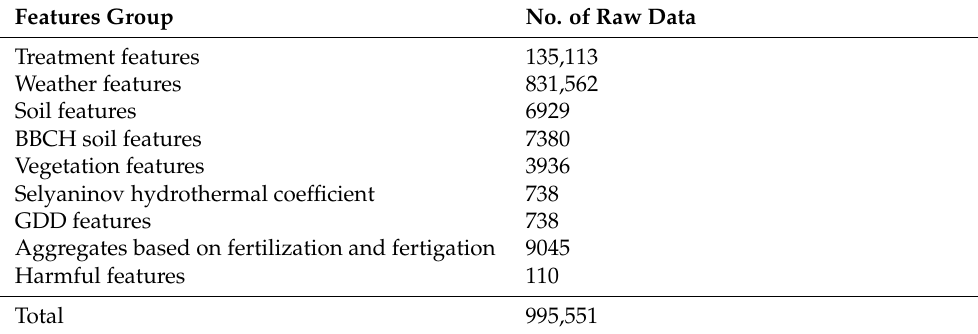
Table 2. Summary of raw data.